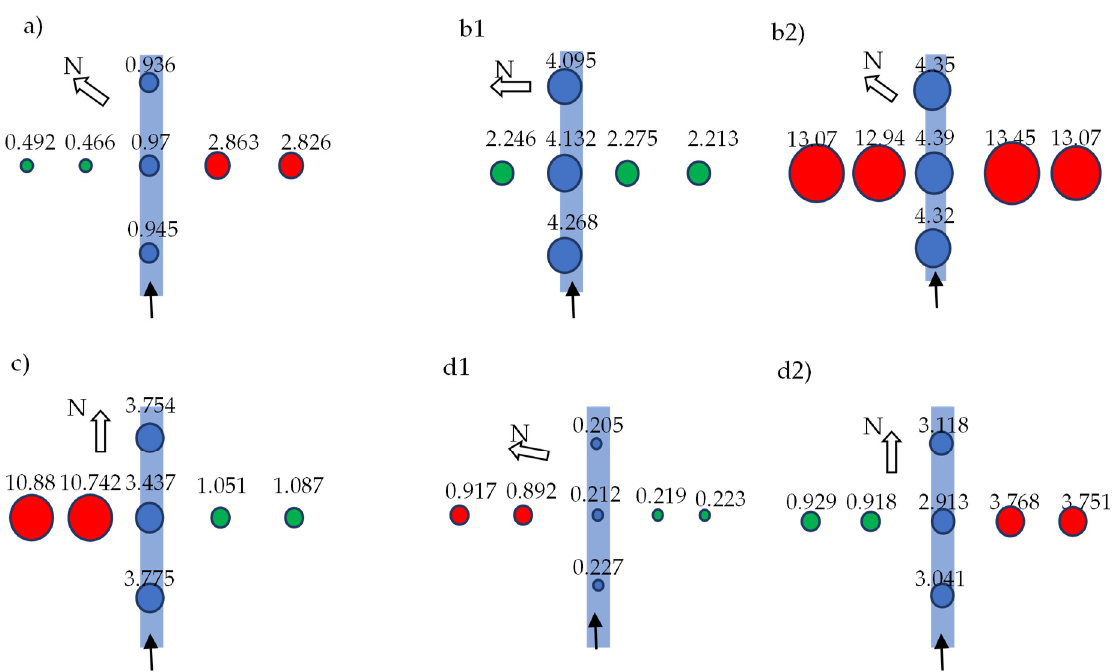
Figure 6. Concentrations of nitrate nitrogen (NO 3 -N) in the groundwater of rivers and boreholes. Blue dots refer to the surface water samples, green dots refer to the ground water samples taken in organic farming areas and red dots refer to the ground water samples taken in intensive farming areas: ( a ) Alšia, ( b1 ) and ( b2 ) Žem ė pl ė ša, ( c ) Šuoja, ( d1 ) Romatas and ( d2 ) Lomena.